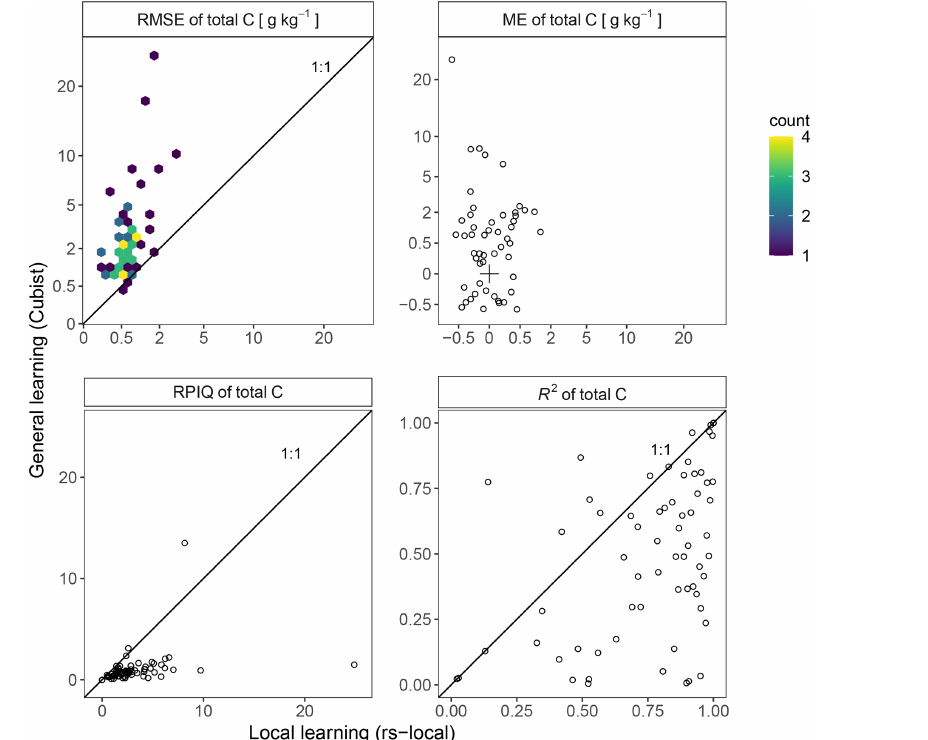
Figure 6. Model assessment of the estimated total carbon (C) of 71 NABO sites for the general learning with CUBIST ( y axis) vs. local learning transfer with RS-LOCAL ( x axis). The four panels depict the root mean square error (RMSE), the mean error (ME), the ratio of performance to interquartile distance (RPIQ) and R 2 . The 1:1-line emphasizes the difference between the two